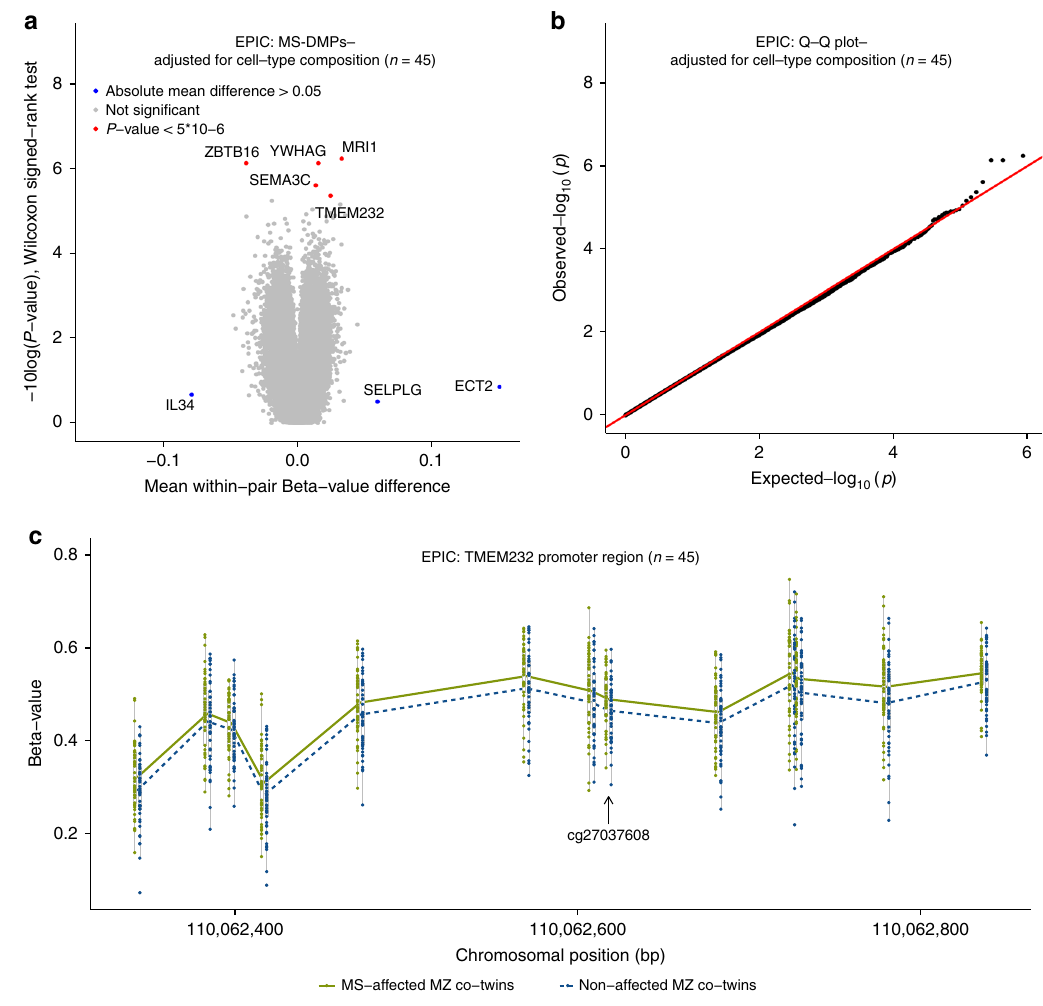
Fig. 2 DNA methylation changes associated with the clinical manifestation of MS. Results of the differential DNA methylation analysis including the EPIC array data of the 45 MZ twin pairs clinically discordant for MS. a Volcano plot of the p -values resulting from the nonparametric two-tailed Wilcoxon signed-rank test against the mean within-pair β -value difference for each CpG. Data were adjusted for cell-type composition. b Q-Q plot of the p- values resulting from the nonparametric two-tailed Wilcoxon signed-rank test shown in Fig. 2a. Data were adjusted for cell-type composition. Within-pair β -value difference ( Δβ -value) = clinically MS-affected MZ co-twin — non-affected MZ co-twin. c Overview of the TMEM232 promoter region. Data are presented as Tukey boxplots including the individual data points that represent the (adjusted) β -values of the signi fi cant MS-associated differentially methylated CpG position (MS-DMP) cg27037608 and 12 neighboring CpGs present on the EPIC array. The lines connect the mean methylation values of each CpG site for the MS-affected and clinically non-affected MZ co-twins separately. Boxplots represent the interquartile range or IQR (bottom and top of the box) and 1.5 times the IQR (whiskers). Source data are provided as a Source Data fi le. n = number of twin